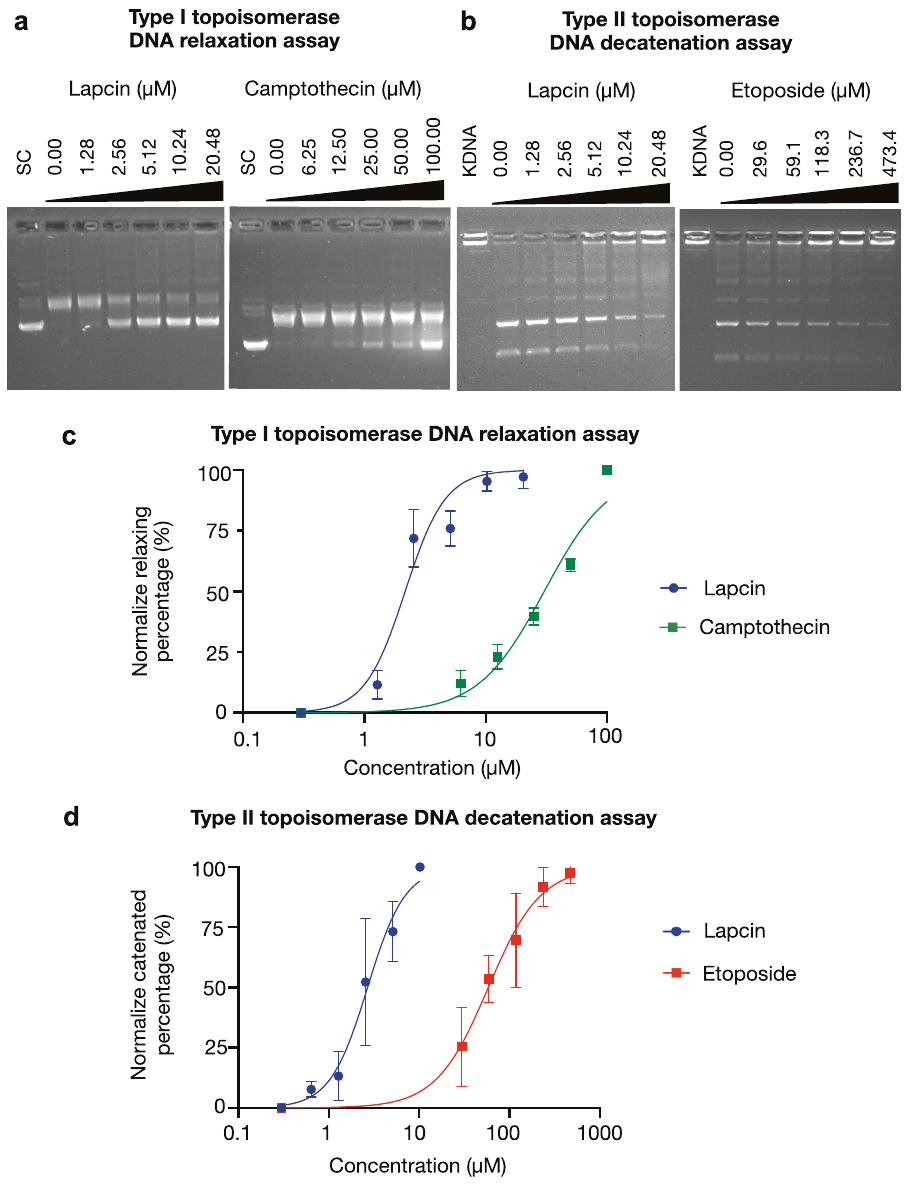
Fig. 4 Topoisomerase inhibition by lapcin. a Type I topoisomerase DNA relaxation assay (SC, supercoil plasmid) b Type II topoisomerase DNA decatenation assay (KDNA, Kineotoplast DNA). c Type I and d II topoisomerase inhibition plots. n = 3 independent assays. Mean value and SD are